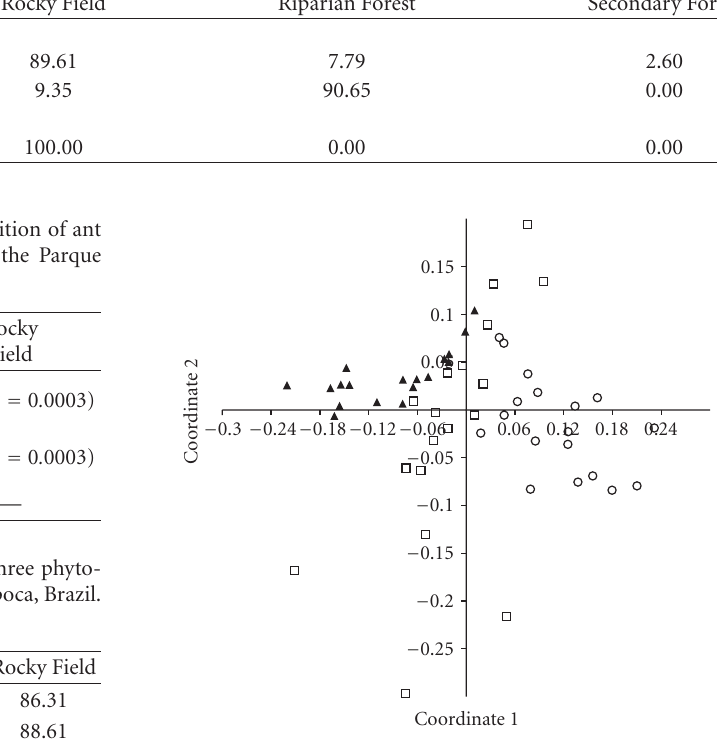
Figure 3: Nonmetric multidimensional ordination (NMDS) of ant species composition in three phytophysionomies sampled in the Parque Estadual do Ibitipoca, Brazil. July–December, 2008. Secondary Forest (triangles), Riparian Forest (squares), and Rocky Field (circles). Stress value =